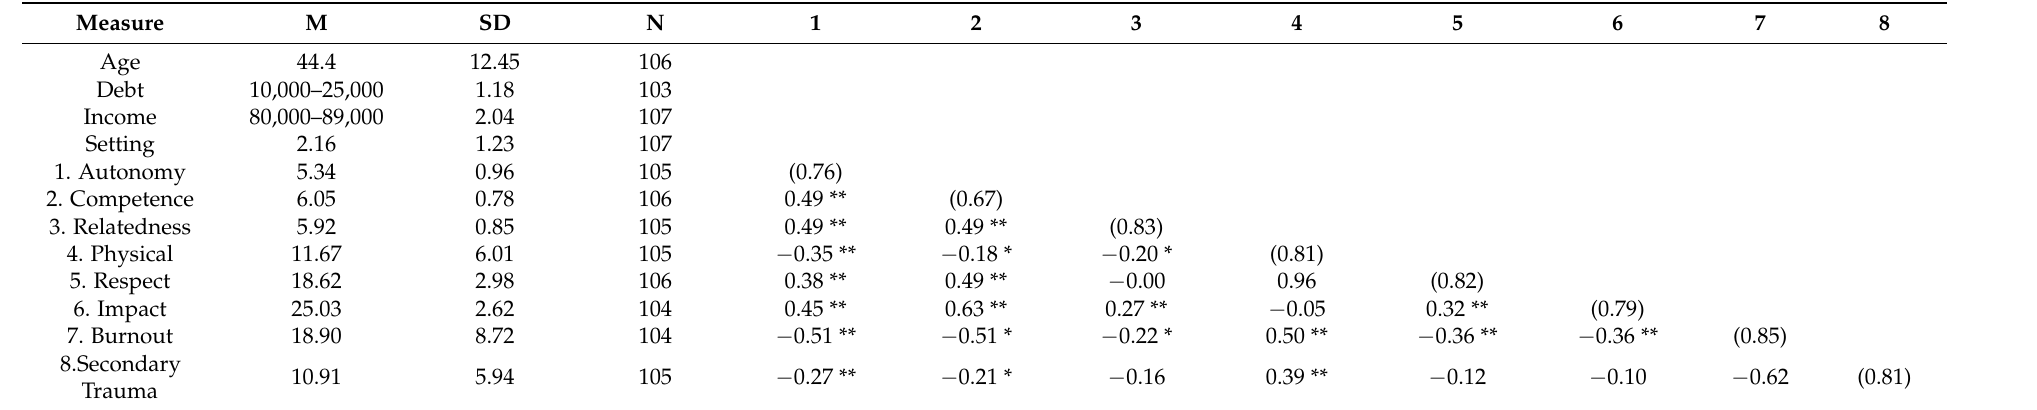
Table 3. Means, standard deviations, sample sizes, internal consistencies and correlations between the